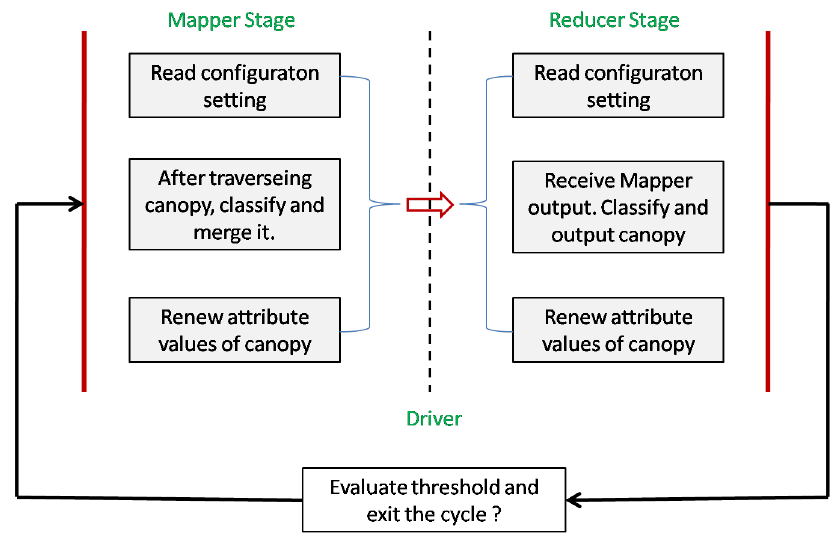
Figure 7. Storage structure of image data in MapReduce